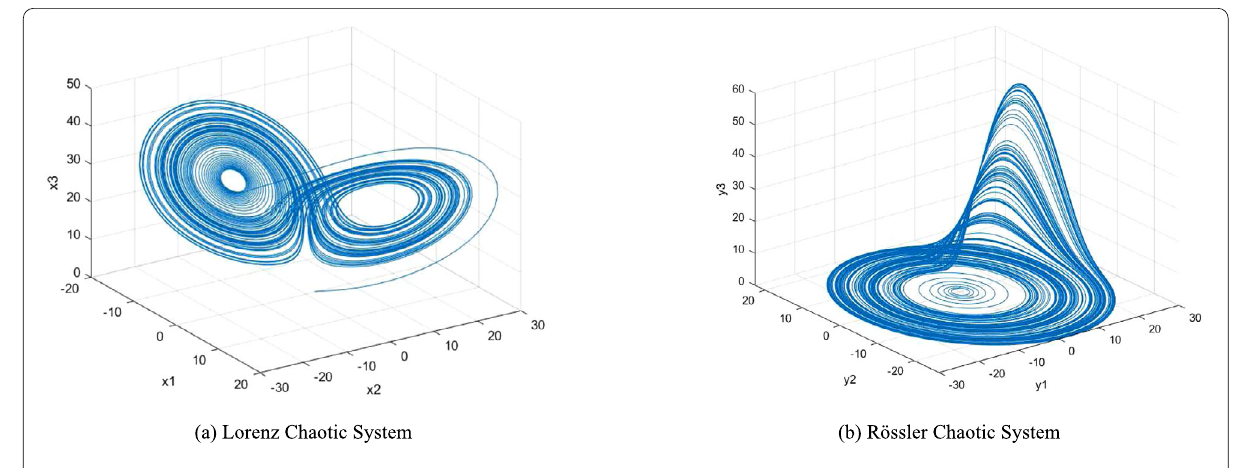
Figure 1 Chaotic system